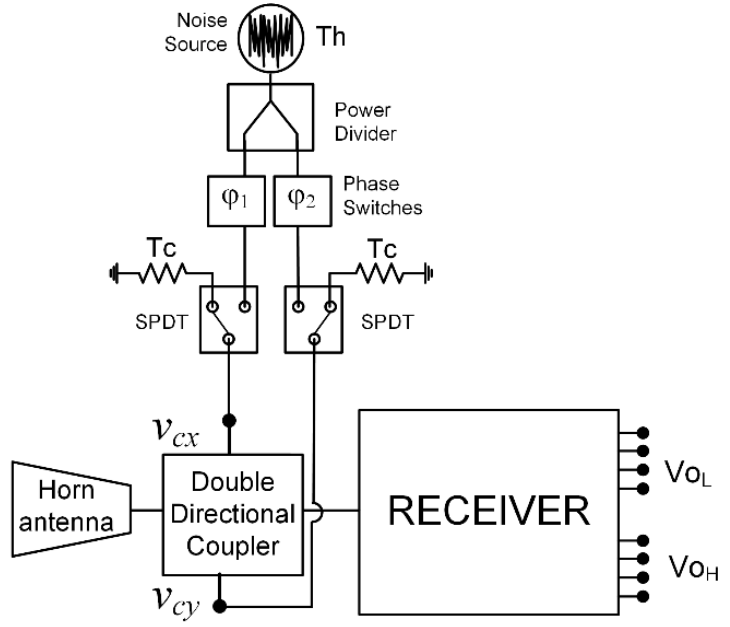
Figure 2. Schematic description of the signal calibration injector.